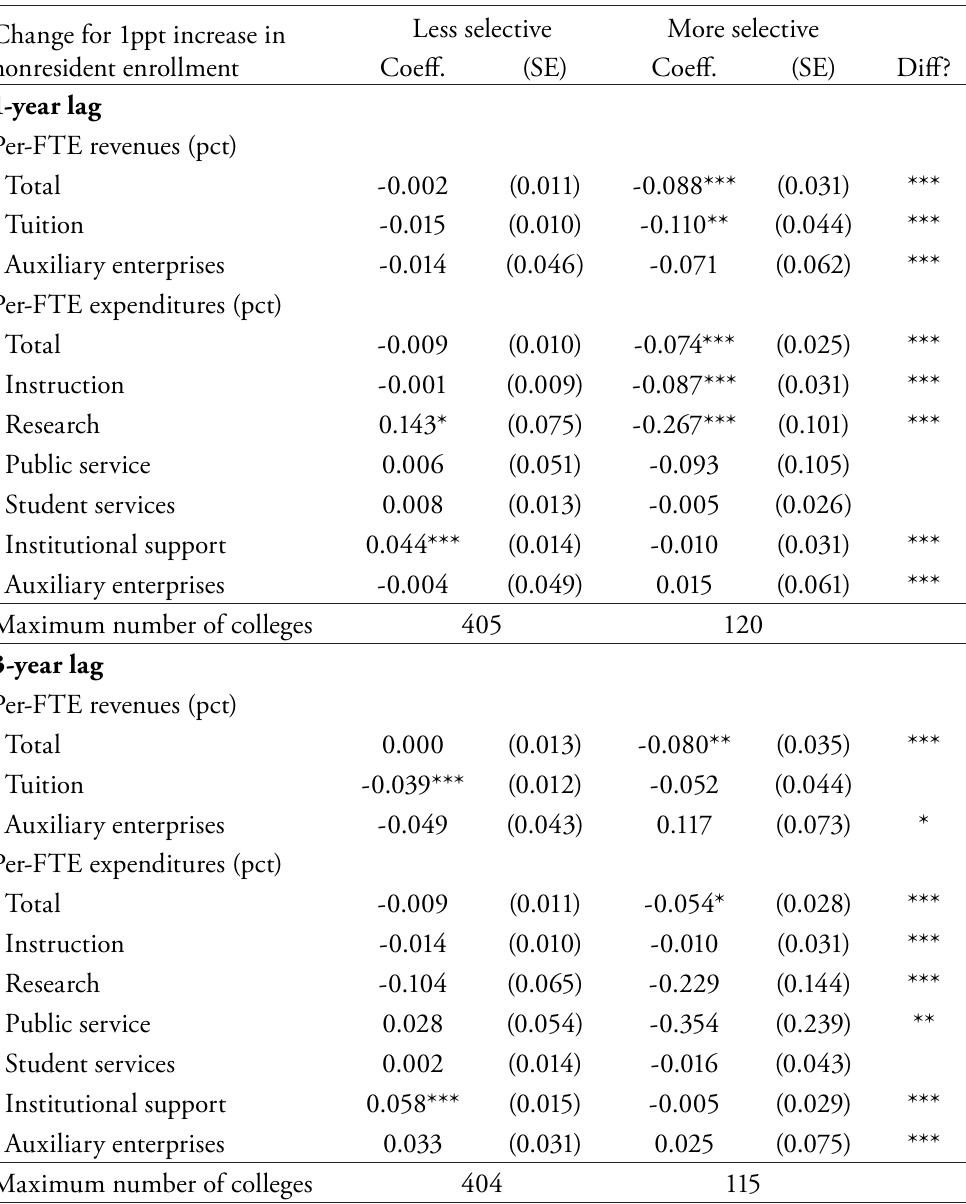
Table 4: Regressions between the percentage of nonresident students and college finances by